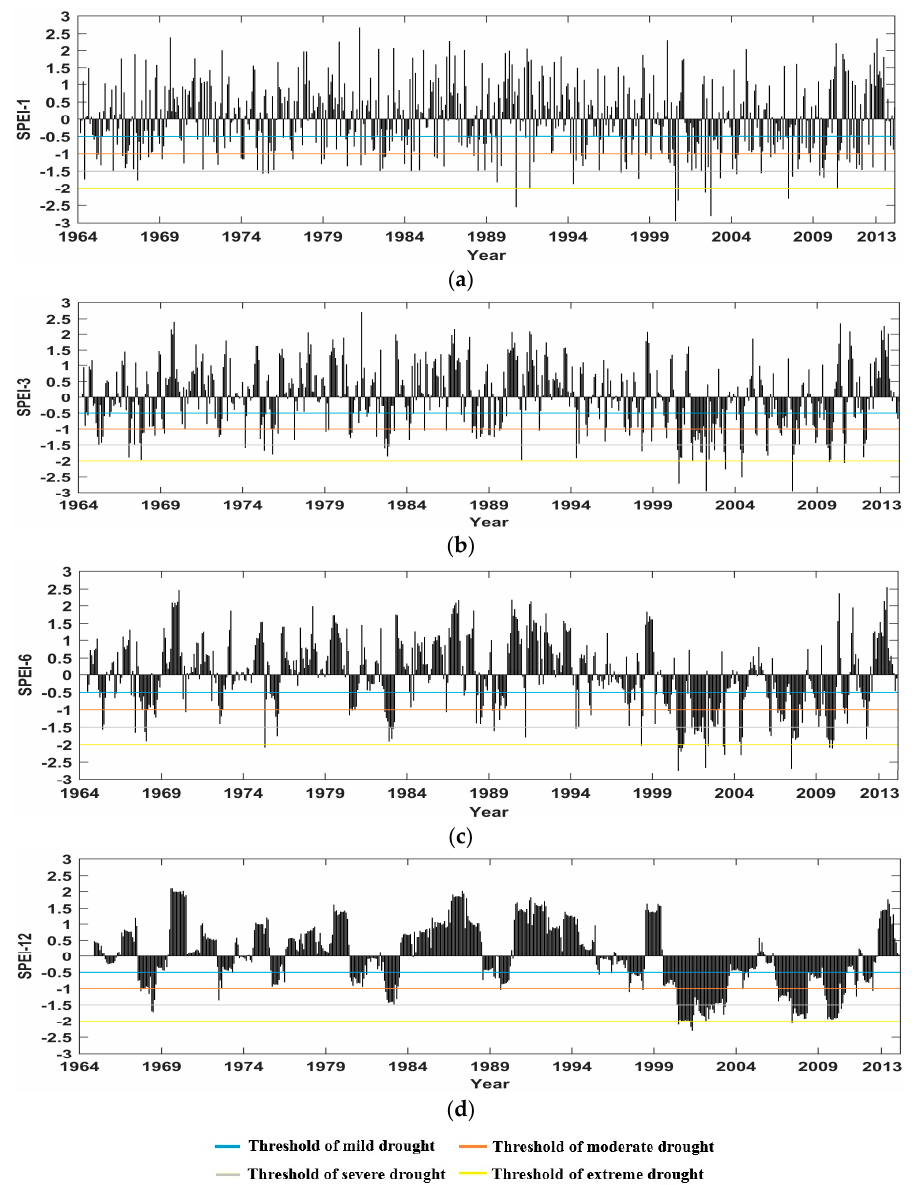
Figure 2. Time series variability of the SPEI-1 ( a ); SPEI-3 ( b ); SPEI-6 ( c ); and SPEI-12 ( d ) from 1964–2013 in Horqin Sandy Land.